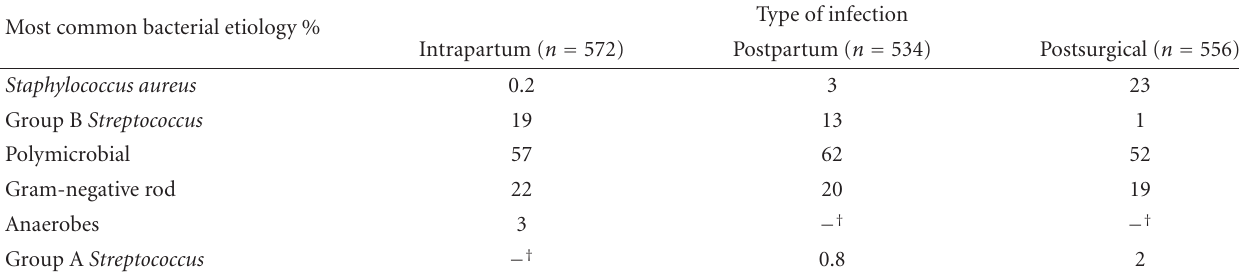
Table 2: Respondents’ perception of most common bacterial etiology of intrapartum, postpartum, and postsurgical infections ‡ . Type of infection Most common bacterial etiology % Intrapartum ( n = 572) Postpartum ( n = 534) Postsurgical ( n = 556) Staphylococcus aureus 0.2 3 23 Group B Streptococcus 19 13 1 Polymicrobial 57 62 52 Gram-negative rod 22 20 19 3